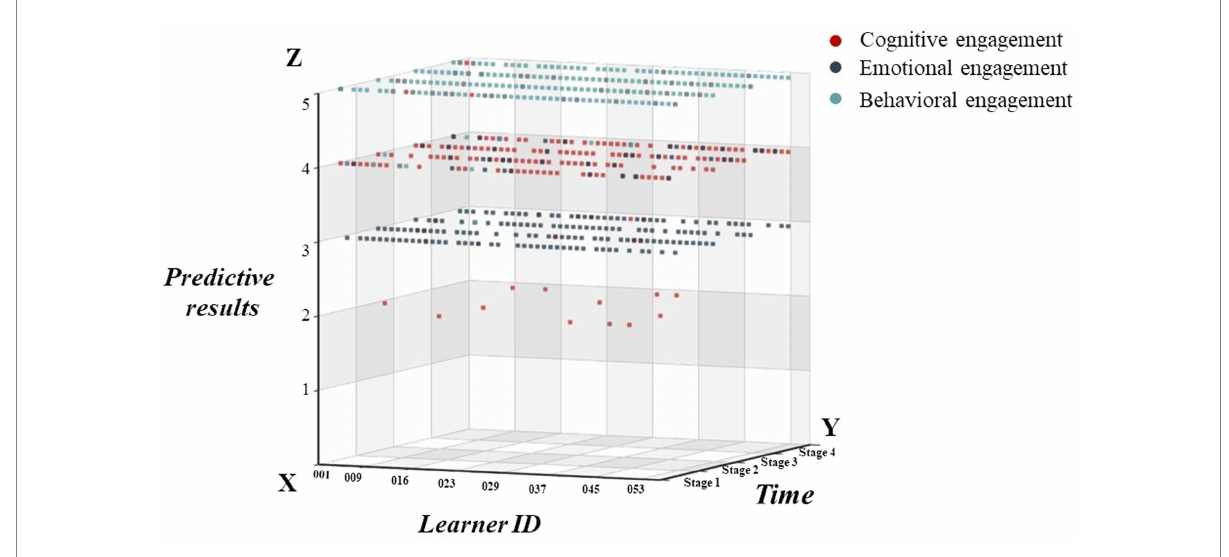
FIGURE 4 Spatial and temporal distribution coordinates of